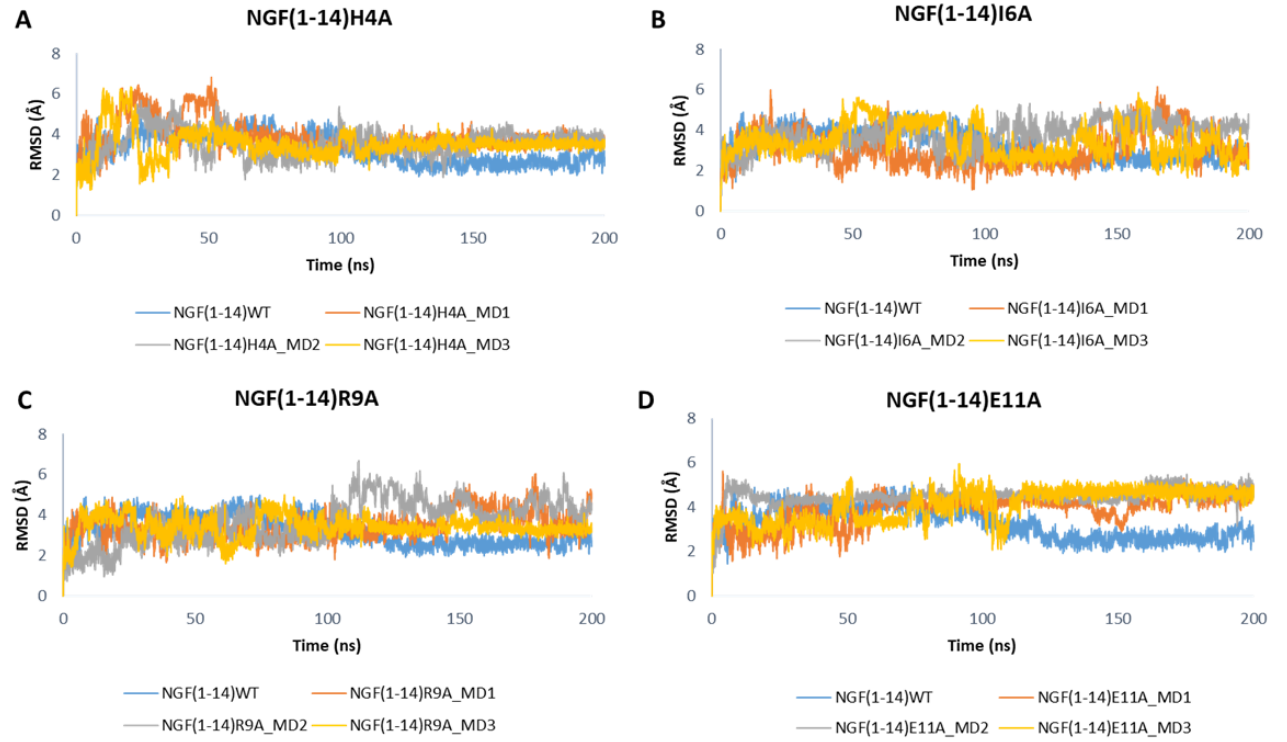
Figure 9. RMSD profiles of the backbone of NGF(1–14) mutants H4A ( A ), I6A ( B ), R9A ( C ) and E11A ( D ) obtained for each MD run.